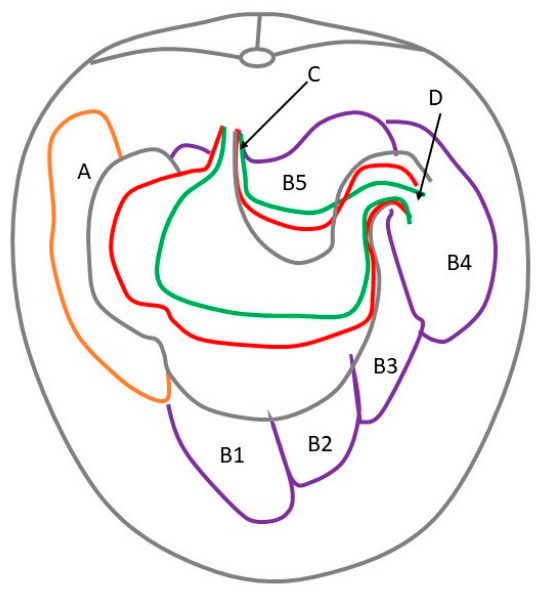
Figure 3. Topography of the stomach in the fetal period (caudal view). Green—first age group; red—second age group; black—third age group; A—spleen; B1—liver, left lateral lobe; B2—liver, left medial lobe; B3—liver, quadrate lobe; B4—liver, right lobe; B5—liver, caudate lobe; C—cardiac orifice; D—pyloric orifice.